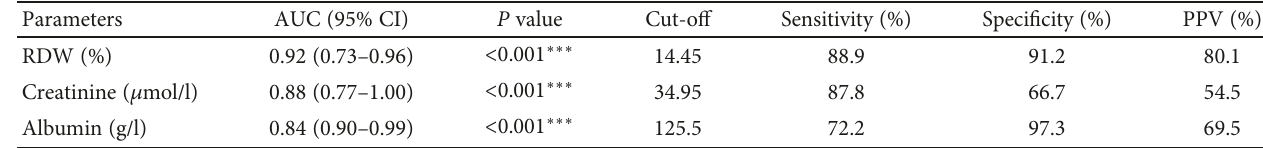
RDW: red cell distribution width; AUC: area under the curve; PPV; positive predictive value. ∗∗∗ P < 0 001